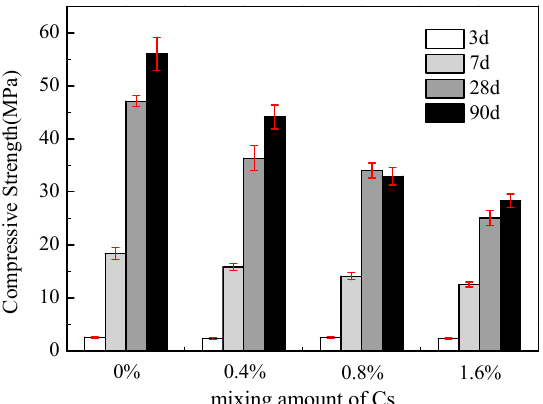
Figure 2. Compressive strength of M–S–H cement samples with different amounts of Cs + after 3, 7, 28 and 90 d.